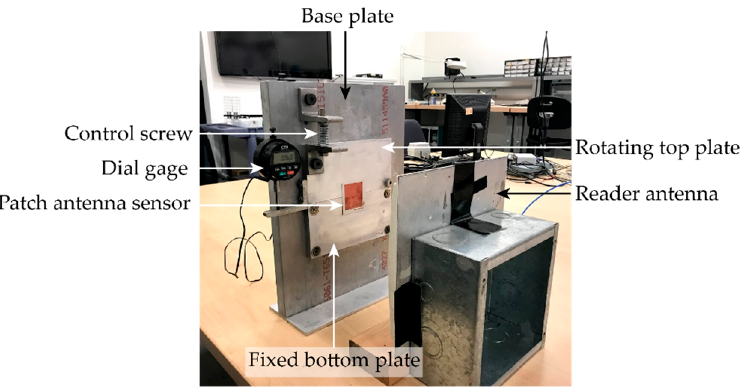
Figure 12. Experimental setup for the emulated crack test.